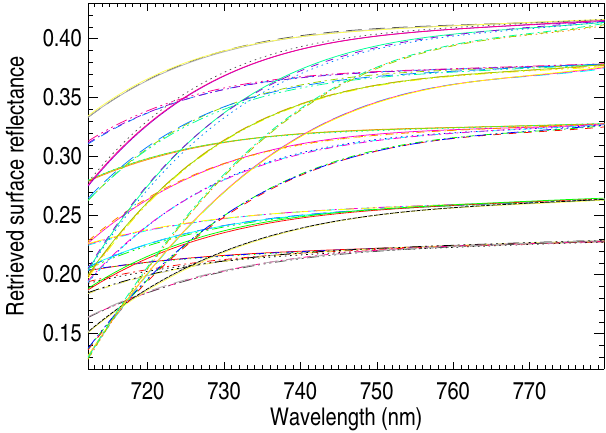
Fig. 11. Retrieved spectral surface reflectances for the range of conditions in the simulated data set. 31